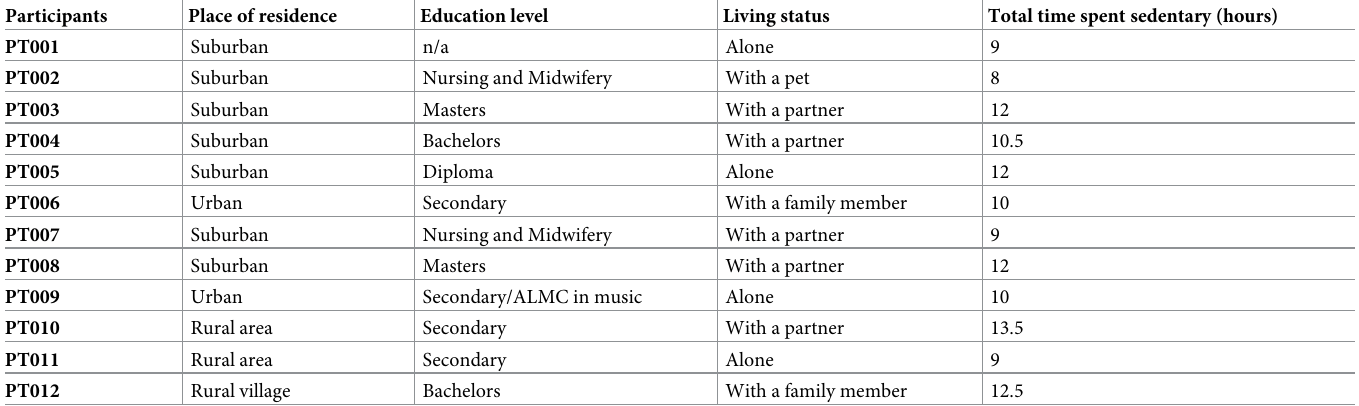
Table 4. Participant Demographic Information (2).